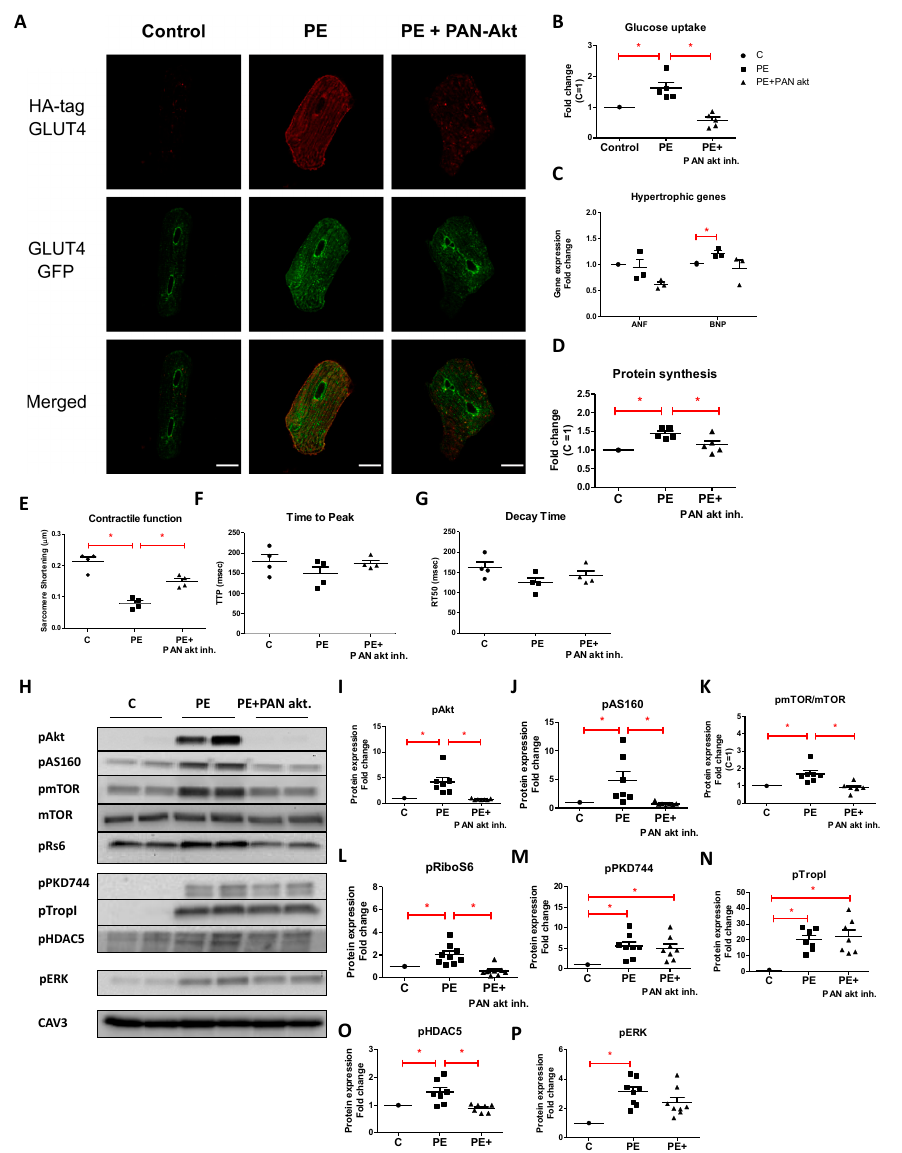
Figure 5. The effect of the PAN-Akt inhibitor (5 µM) on GLUT4 translocation, glucose uptake, hypertrophic gene expres- sion, protein synthesis, contractile function, and cellular signaling after co-treatment with PE (50 µM) for 24 h. GLUT4 translocation (scale bar 20 µm) (representative confocal images of n = 3, see Supplemental Figure S2) ( A ), glucose uptake ( n = 5) ( B ), hypertrophic gene expression ( n = 3) ( C ), and protein synthesis ( n = 5) ( D ) are displayed in fold increase relative to control. ( E – G ) Contractile properties upon 1 Hz electric-field stimulation: sarcomere shortening, time to peak, and decay time. Values are expressed as means ± STDEV ( n = 4). ( H ) Representative Western blots showing phosphorylation levels of proteins involved in the Pi3K/Akt/mTOR-pathway (p-Akt(Ser473), p-AS160(Thr642), p-mTOR(ser2448), mTOR, and p- rS6(Ser235/236)) and the PKD1-pathway (p-PKD1(ser744), p-PKD1(ser916), p-TropI(Ser23/24), and p-HDAC5(Ser498)) ( H – O ). Finally, phosphorylation of ERK1/2 (p-ERK1/2-thr202/tyr204) is shown ( P ). For quantification, protein levels were normalized to Caveolin 3 (CAV3). Values are expressed as fold increase ± STDEV relative to control ( n = 7/ n = 9). * p < 0.05 was considered significantly different compared to control.